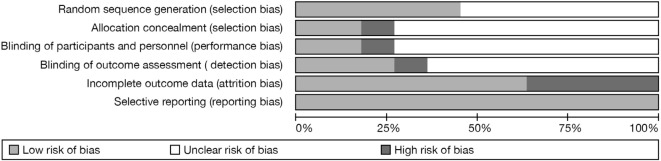
Risk of bias graph.